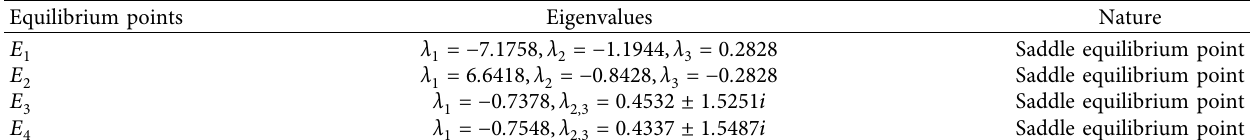
Table 1: Equilibrium points, corresponding eigenvalues, and their